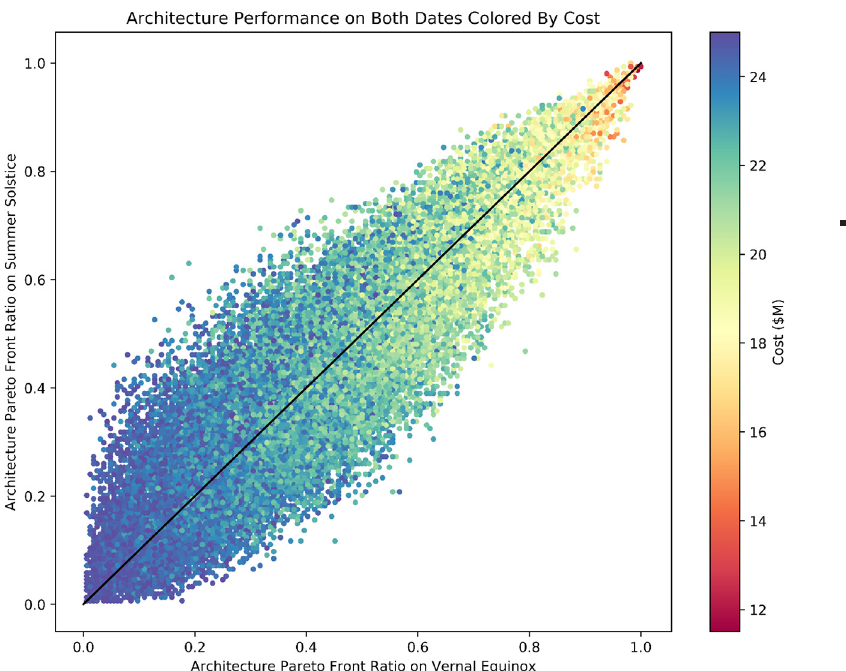
Figure 5. Relative architecture performance on both days (higher- performing architectures